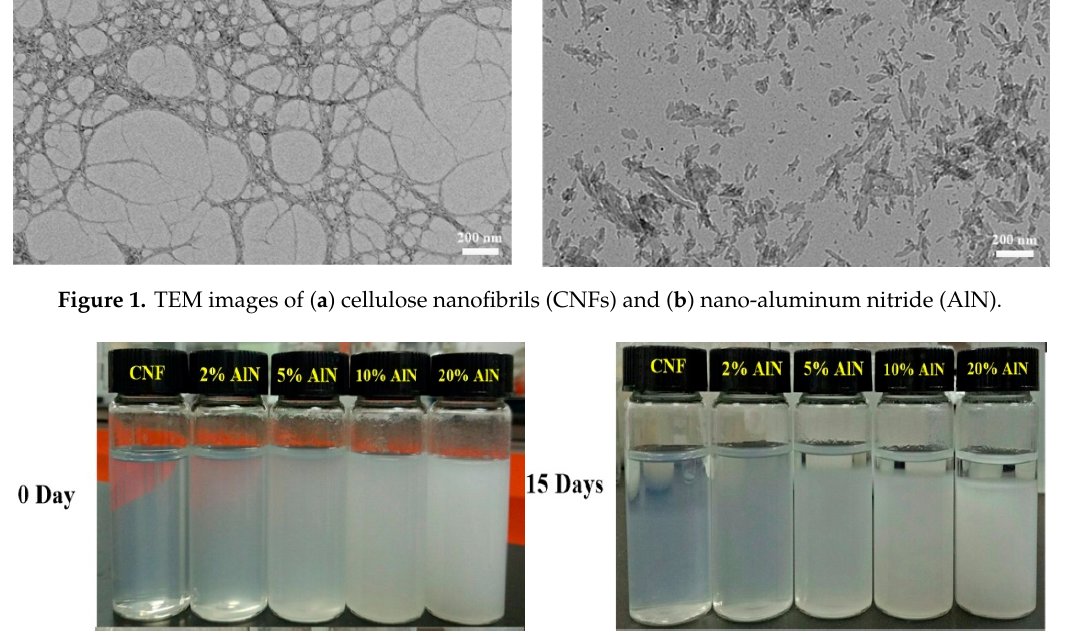
Figure 2. CNF-AlN suspensions with different contents.